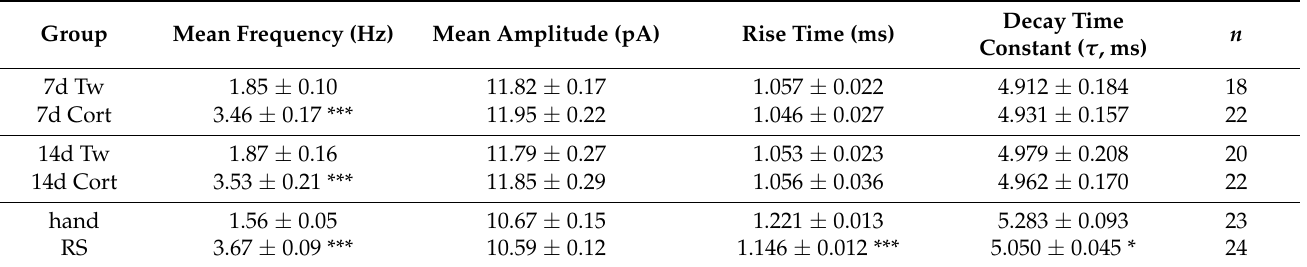
Table 2. Effects of corticosterone and restraint stress on parameters characterizing sEPSCs (mean ± SEM).